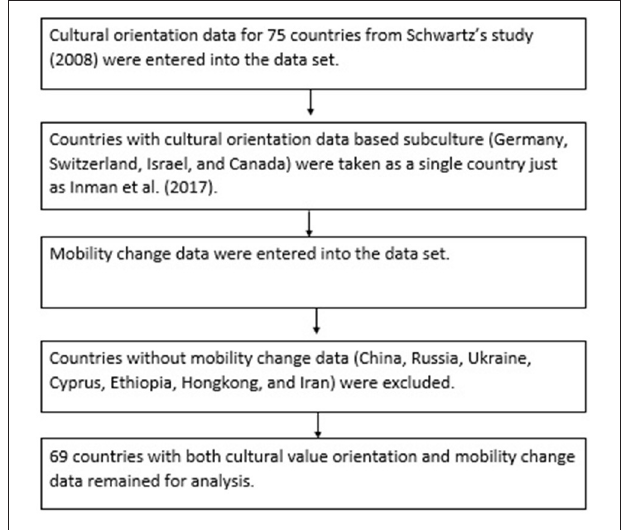
FIGURE 1 | Data integration